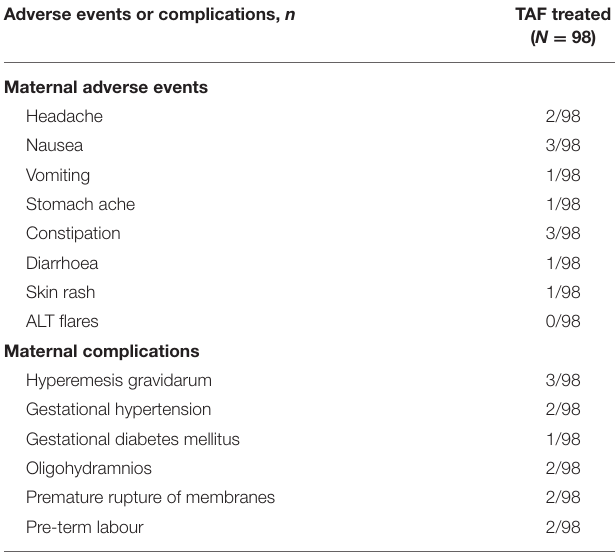
TABLE 3 | Maternal adverse events and complications reported in the study.